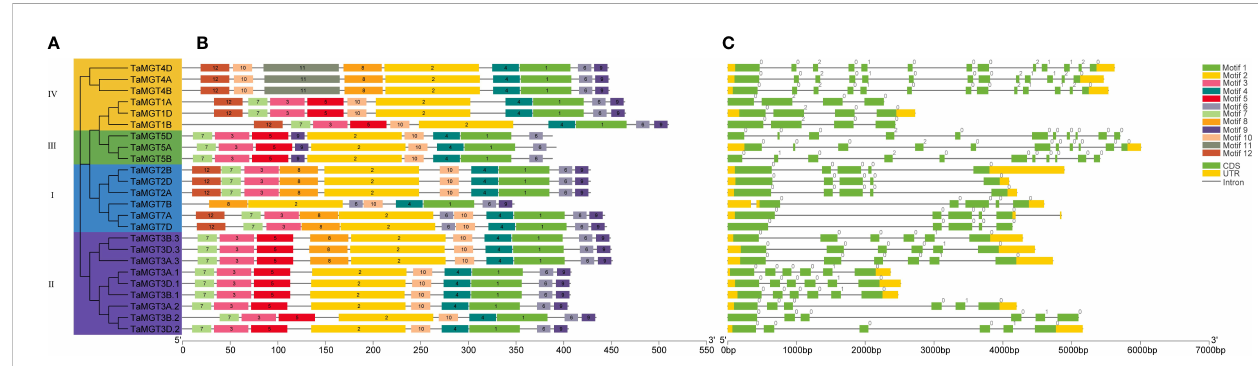
FIGURE 3 Phylogenetic relationships (A) , motif analysis (B) and gene structure (C) of TaMGT family